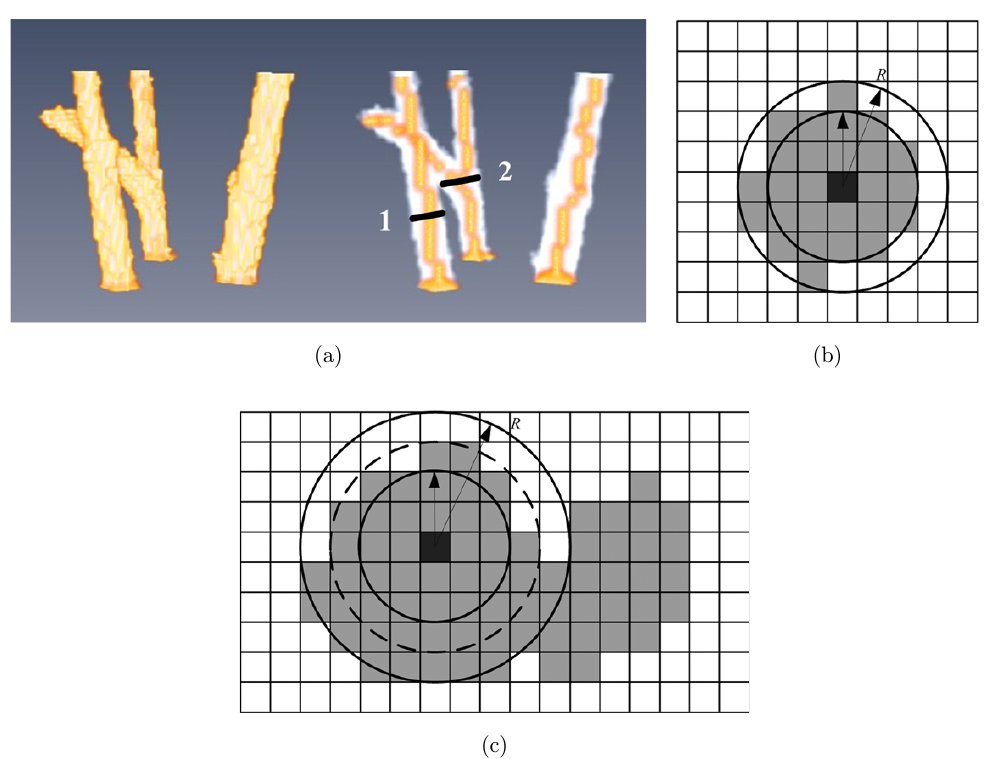
Fig. 6. The method used to ¯nd a tiller in a section plane. (a) Part of the voxel model of a tiller, and the tiller axis mapping in the model. Two sections are shown in (b) and (c) that correspond to labels 1 and 2 in (a), respectively. A simple tiller section is shown in (b), and (c) shows a tiller section with a connected leaf. The black pixels represent the axis and the gray pixels represent the